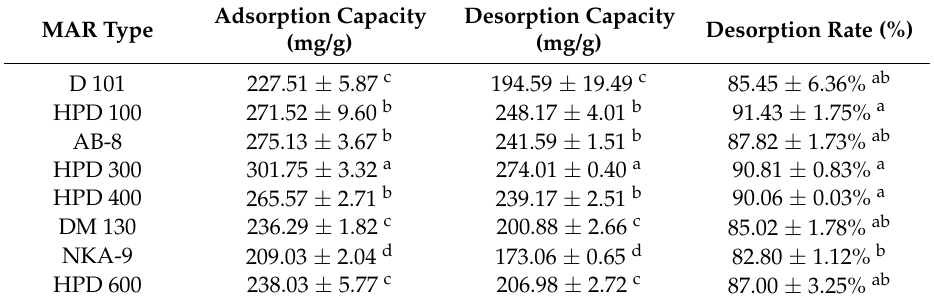
Table 2. The adsorption and desorption characteristics of total polymethoxylated flavones (PMFs) on eight macroporous